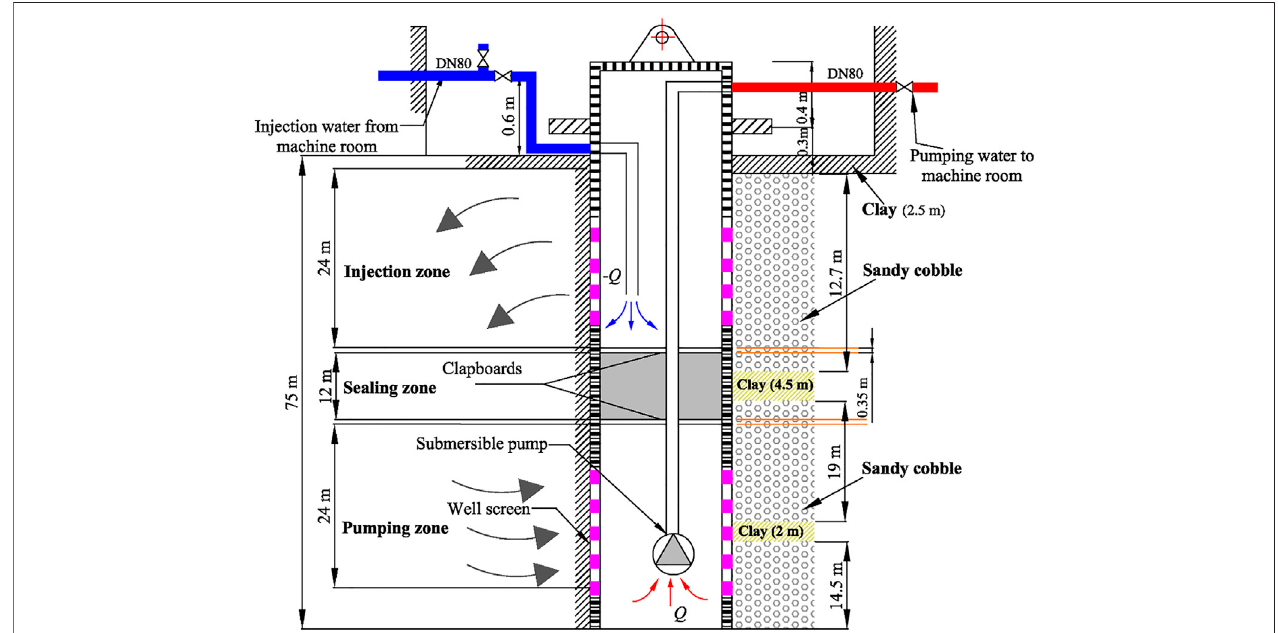
FIGURE 1 | Schematic diagram of the SWC